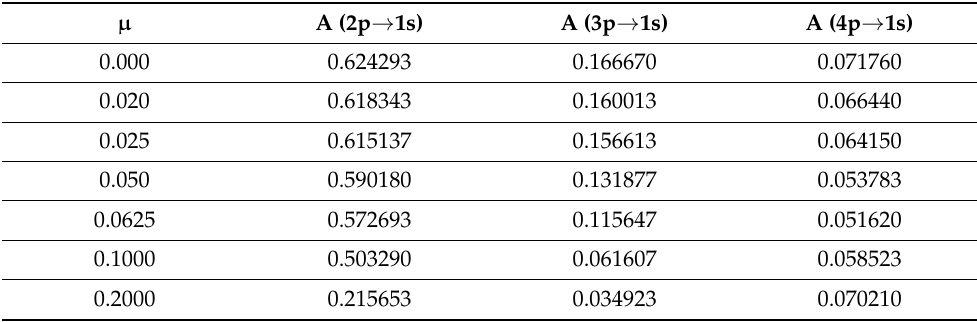
Table 5. Transition rates in sec ( − 1) 4p, 3p and 2p states of hydrogen atoms to the 1s state. The rates have been multiplied by 10 ( − 9)